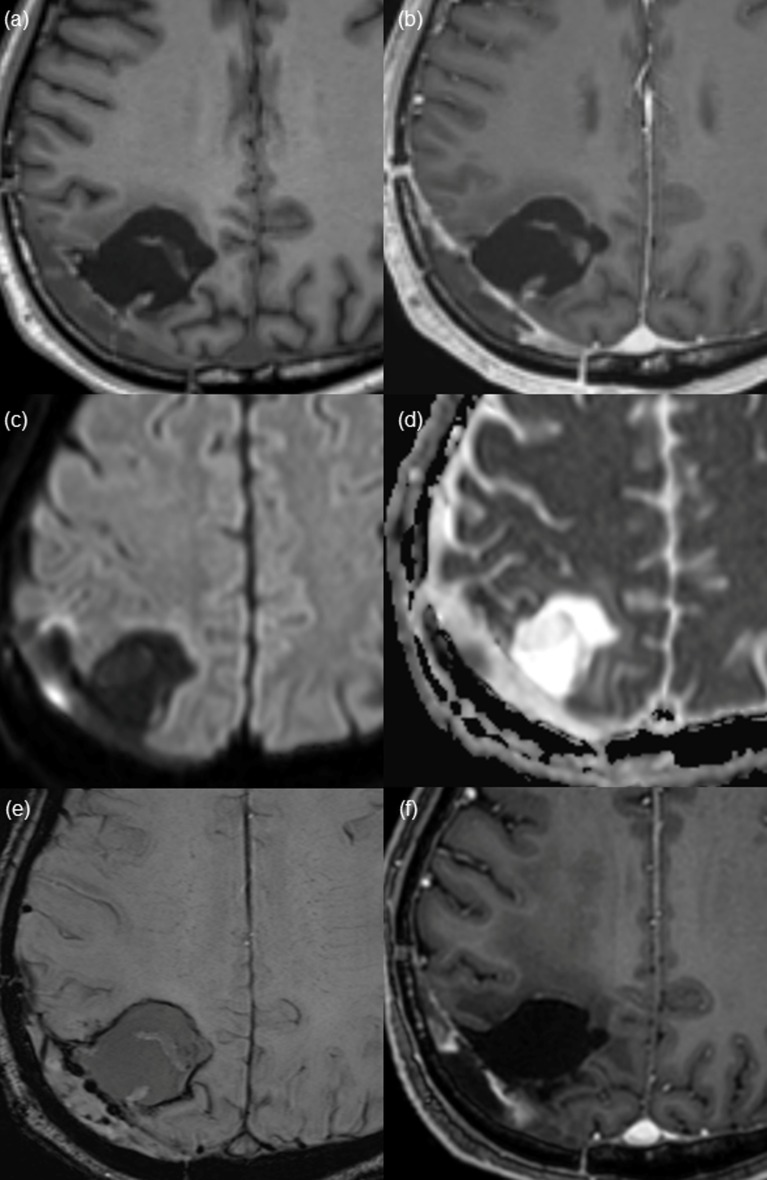
Thin wall enhancement pattern of the surgical cavity found on post-CCRT magnetic resonance (MR) imaging from a 71-year-old patient after gross total resection of glioblastoma.(a and b) Pre- and post-contrast enhanced T1 WI shows thin linear enhancement along the surgical cavity wall. (c) DWI and corresponding (d) ADC map suggest the possibility of diffusion restriction. However, considering the dark signal intensity on SWI (e), high SI on DWI reflects hemorrhage and does not suggest true diffusion restriction. (f) After 20 months, on the last follow up image, no measurable enhanced lesion is shown on contrast-enhanced T1WI.